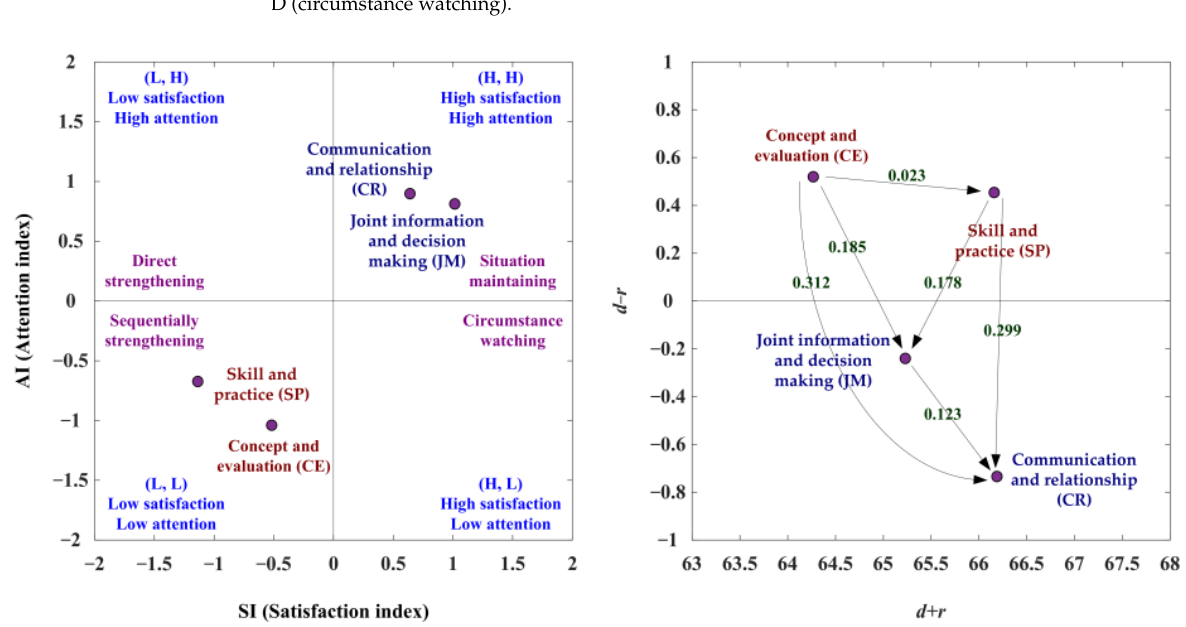
Table 3. The analysis of reliability (Cronbach  ).